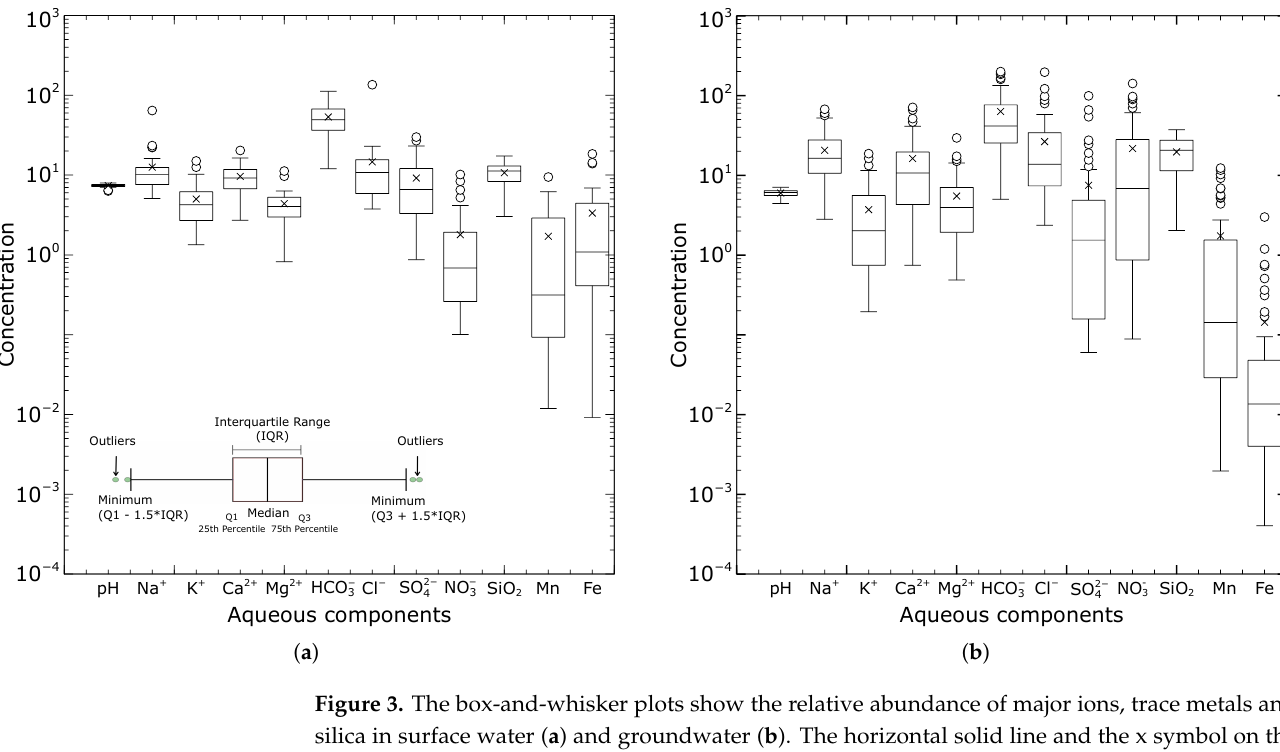
Figure 3. The box-and-whisker plots show the relative abundance of major ions, trace metals and silica in surface water ( a ) and groundwater ( b ). The horizontal solid line and the x symbol on the box-and-whisker plot represent the average and the median concentrations, respectively. Outliers are defined by points that fall more than 1.5*IQR above the third quartile or below the first quartile. All the ion concentrations are measured in mg/L except